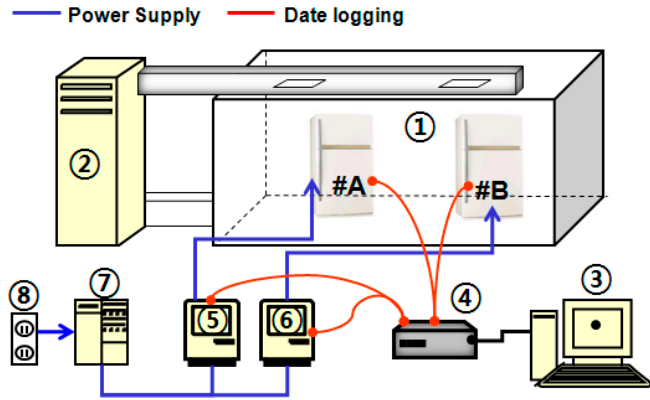
Figure 3. Arrangement of experimental apparatus.